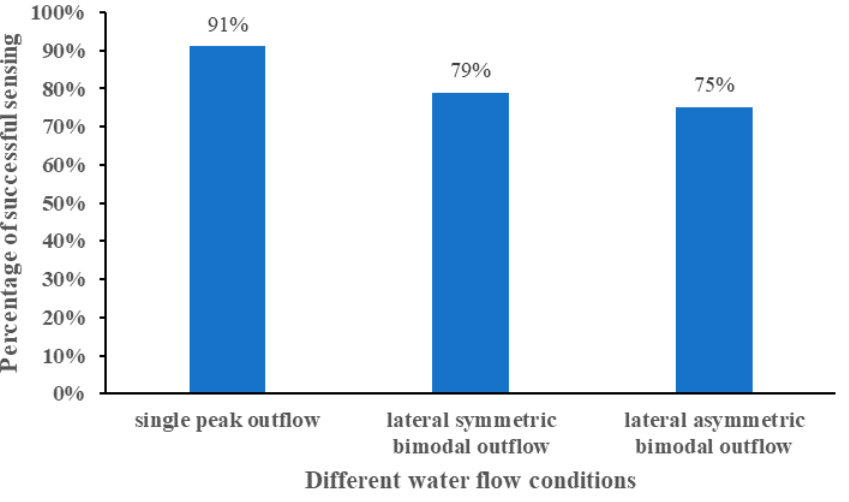
Figure 9. Average sensing success rate under different water flow conditions. Table 2. Analysis of variance